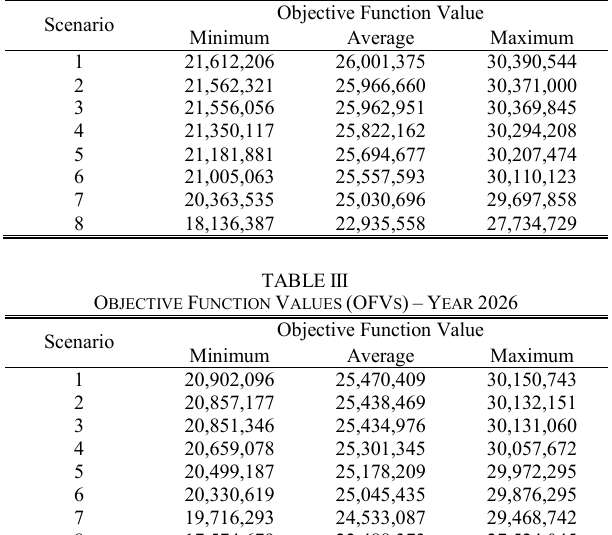
Table I. TABLE II O BJECTIVE F UNCTION V ALUES (OFV S ) – Y EAR 2016